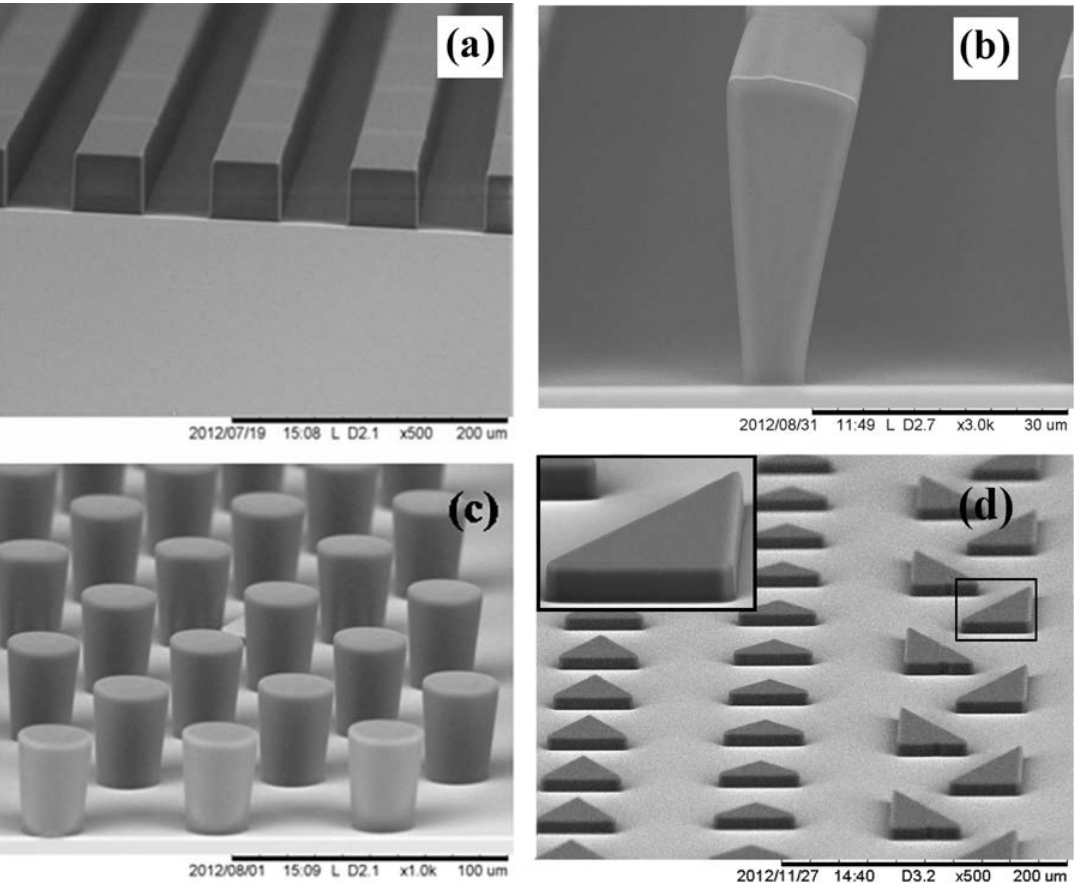
Figure 6. SEM images of optimally exposed ORMOCOMP ® : ( a ) ~50 µm tall ridges patterned with spot size 4 µm and dose 1.46 J·cm −2 ; ( b ) ~50 µm tall and ~10 µm wide ridges patterned with 1 µm spot size and dose 1.6 J·cm −2 ; ( c ) ~50 µm high pillars patterned with spot size 1 µm and dose 0.81 J·cm −2 and ( d ) ~13 µm high triangles patterned with spot size 2 µm and dose 0.82 J·cm −2